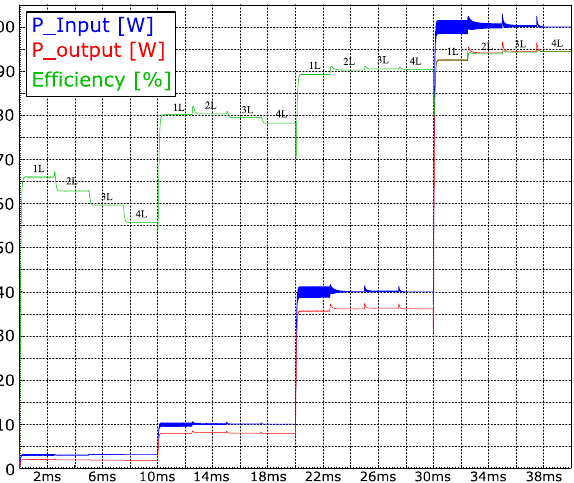
Figure 10. Simulation results achieved by a simulation model of the converter and the help of VHDL script in a Proteus simulation environment.